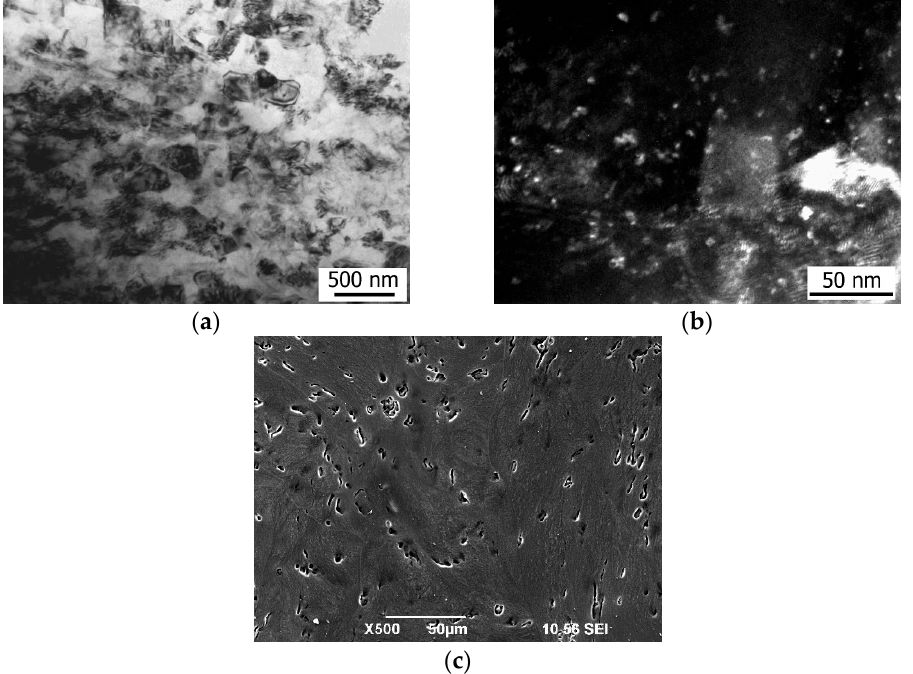
Figure 11. Structure of the Mg-1Ca alloy after HPT processing: ( a ) bright-field image; ( b ) view of the Mg 2 Ca particles in a dark-field image; ( c ) SEM image of the fragmented eutectics.